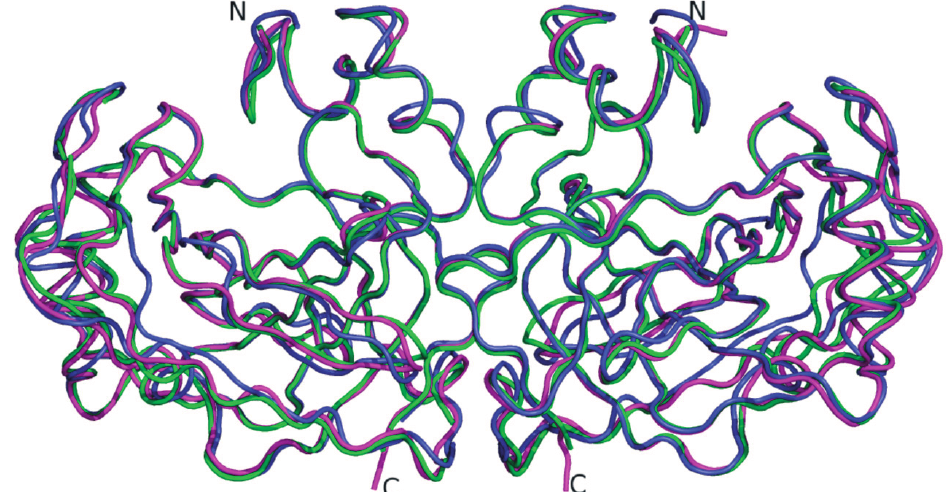
Figure 4. Superposition of the dimeric structure of SazCA (PDB code 4X5S, green) with those of SspCA (PDB code 4G7A, magenta) [67] and TaCA (PDB code 4C3T, blue) [62]. TaCA dimer was generated using PISA program (http://www.ebi.ac.uk) [71] on the crystallographic coordinates (PDB entry